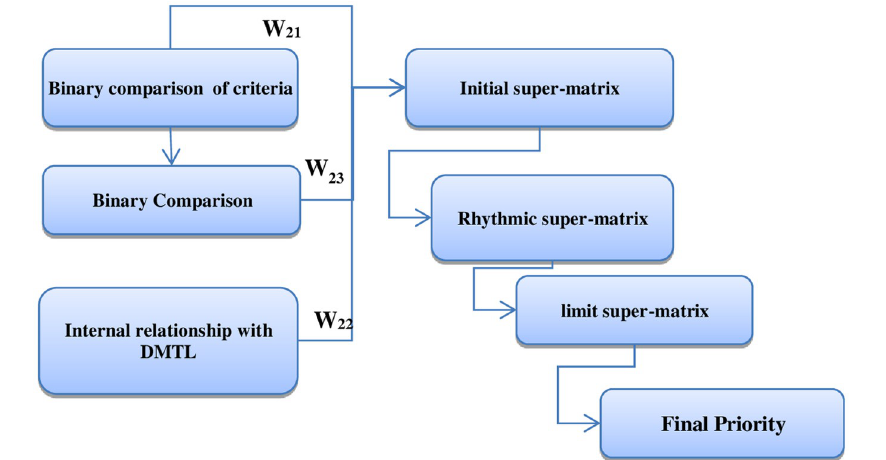
Fig 1. Proposed framework of the ANP-DEMATEL combined approach.